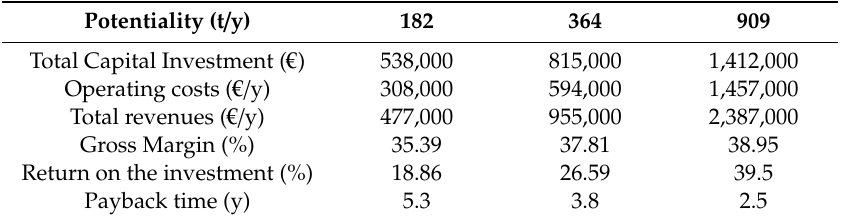
Table 5. Economic evaluation report for the di ff erent